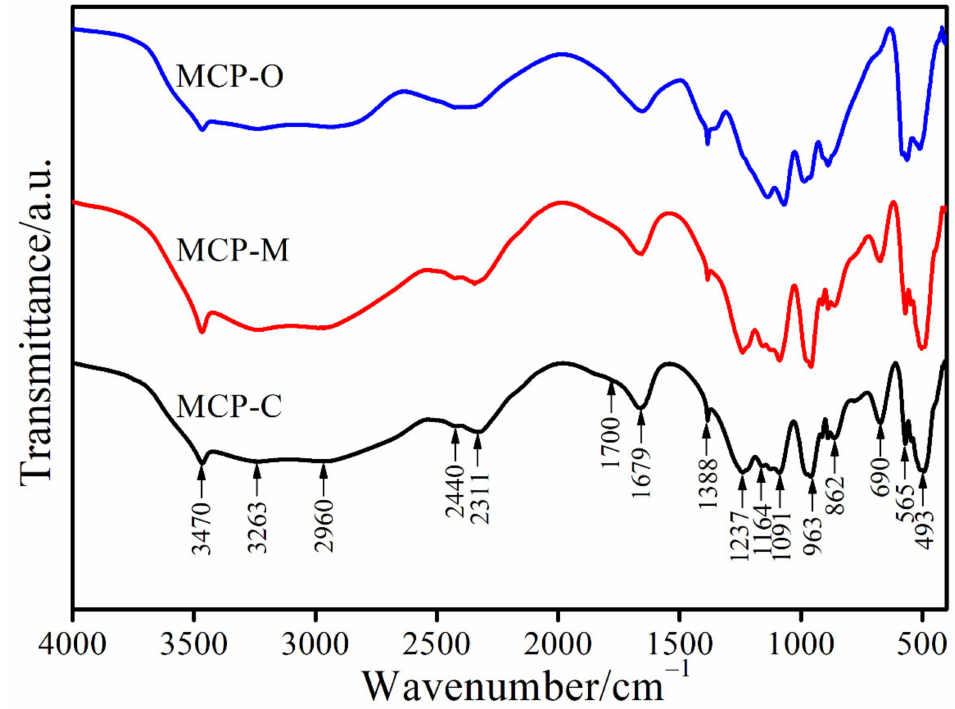
Figure 7. FTIR spectra of MCP-C, MCP-M, and MCP-O samples. X-ray diffraction patterns of the MCP-C, MCP-M, and MCP-O samples (Figure 8) are the same 2 θ positions but intense peaks are different. All detectable peaks of the obtained MCP-C, MCP-M, and MCP-O samples indexed as the Ca(H 2 PO 4 ) 2 · H 2 O structure match with the standard data of PDF no. 70–0090 [41,46]. The XRD patterns exhibit two sharp characteristic peaks at 2 θ = 22.95 and 24.18 ◦ corresponding to (0–21) and (210) reflections for anorthic crystal structure of Ca(H 2 PO 4 ) 2 · H 2 O. The labeled diffraction peaks can be indexed according to standard XRD data and XRD peaks of other phases were not observed, confirming the pure compounds obtained under study. The XRD results and the FTIR data are well